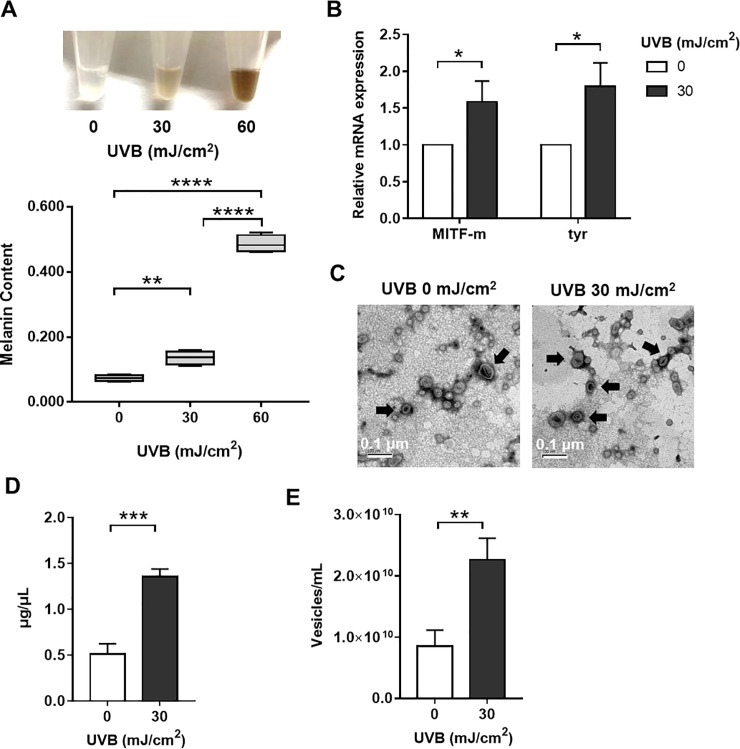
Effect of UVB on the production of melanin and secretion of exosomes by primary melanocytes.(A) Melanocytes irradiated by various doses of UVB and the color of the cell lysis buffer was monitored. The melanin content was measured at 450 nm. The data are representative of three independent experiments (***, P < 0.005; ****, P < 0.0 001). (B) Expression of tyrosinase (tyr) and MITF at the mRNA level was determined by using qRT-PCR (*, P < 0.05). (C) Electron micrographs showed the cup‐shaped vesicles. The arrow indicates exosomes, and the scale bar represents 0.2 μm. Exosomes were then quantified with (D) BCA assay and (E) nanoparticle tracking analysis. (**, P < 0.001; ***, P < 0.0 01).